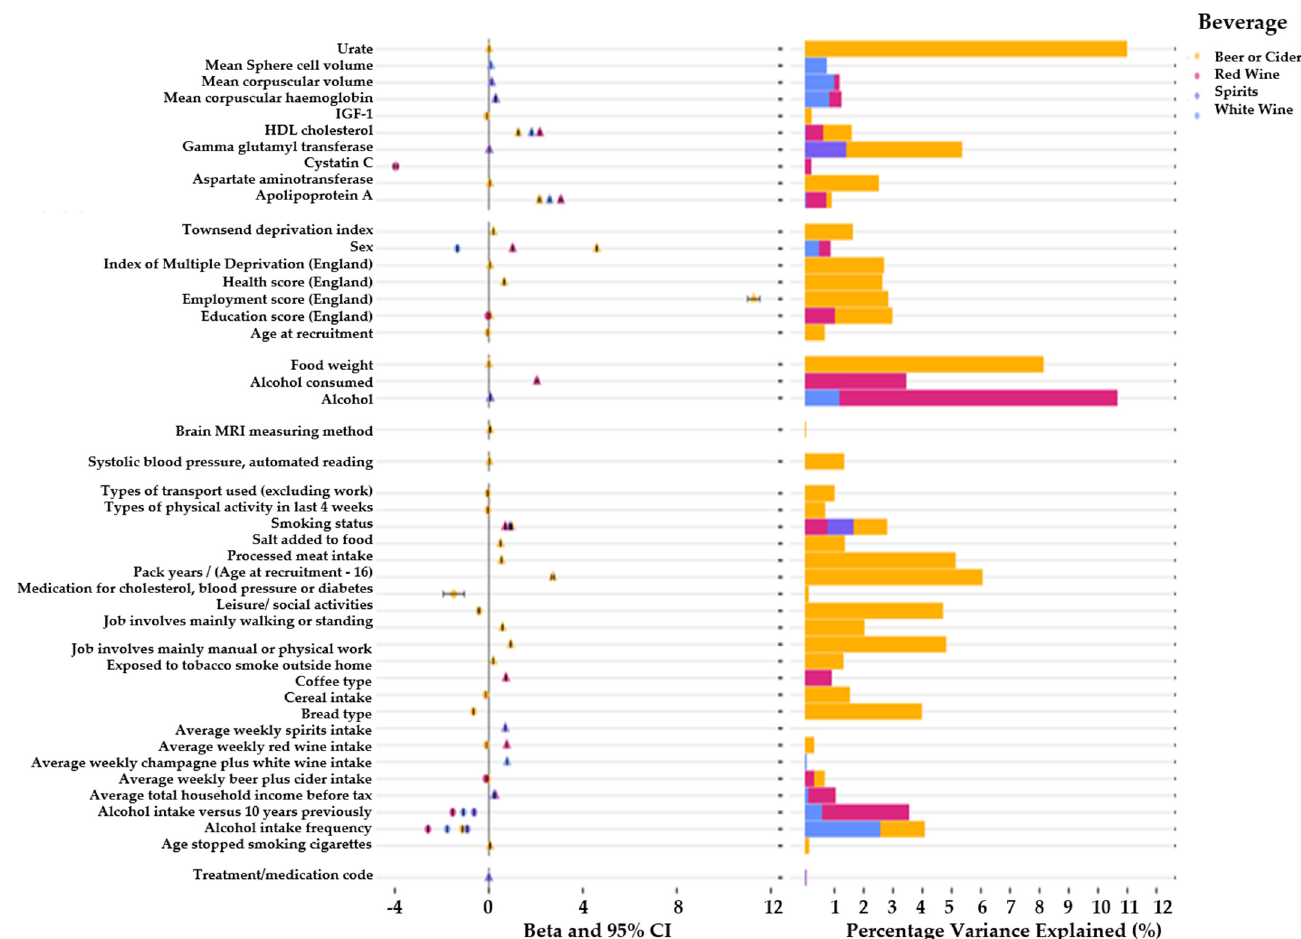
Figure 4. Overview of leading associations between consumption of alcoholic beverages and various phenotypes within the UK biobank. The left panel illustrates the effect estimates and confidence intervals for the leading associations. The right panel illustrates percentage variance explained for association of various alcoholic beverage consumption and UK biobank phenotypes. Beer/cider results are plotted in yellow, red wine results are plotted in pink, spirit results are plotted in purple, and white wine results are plotted in blue.